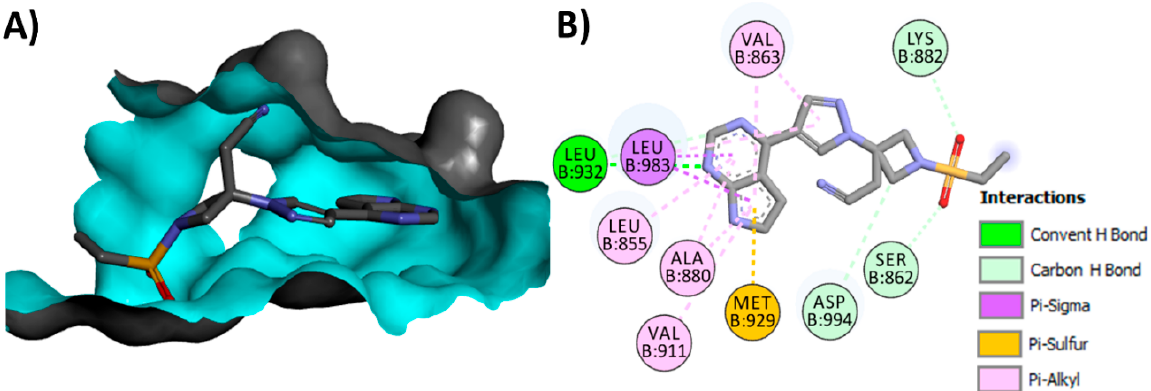
Figure 19. Binding modes of baricitinib (shown as sticks) into JAK2 JH1 (pdb: 6VN8): ( A ) 3D binding mode, receptor shown as a hydrogen bond surface; ( B ) 2D binding mode showing different types of interactions with JAK2 JH1; the figure was generated using Discovery Studio Visualizer (V16.1.0.15350).